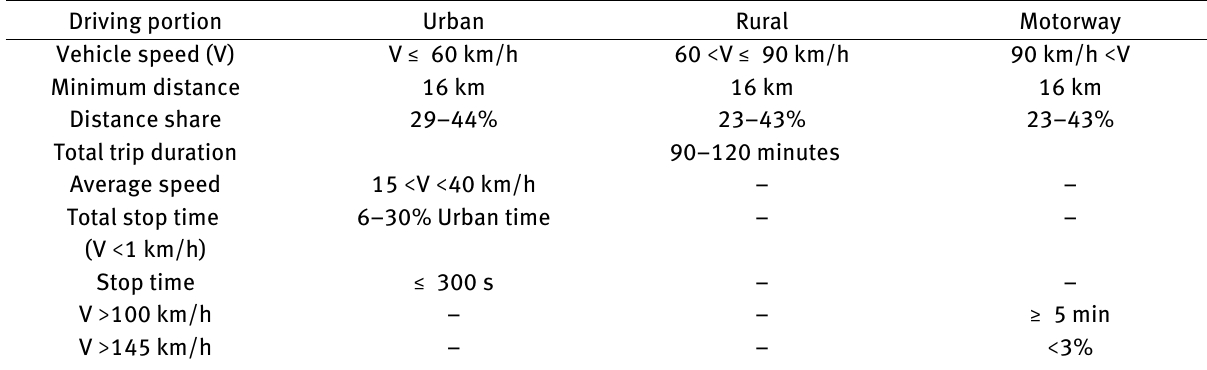
Table 1: Drive cycle requirements for a valid RDE test Driving